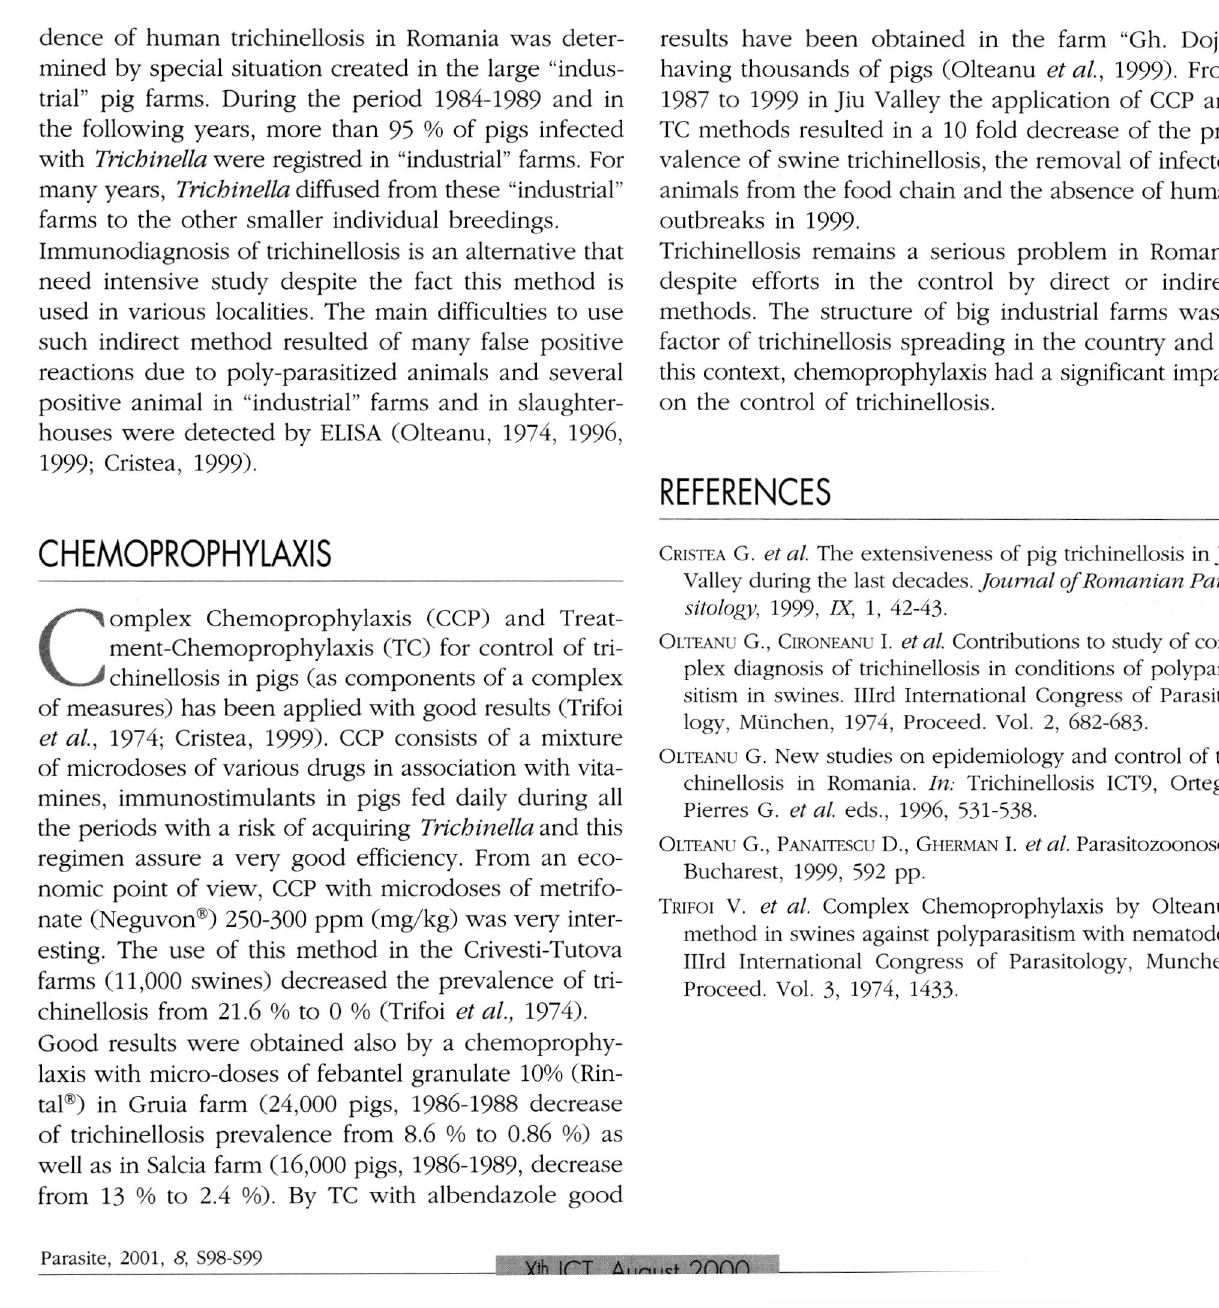
dence of human trichinellosis in Romania was deter mined by special situation created in the large